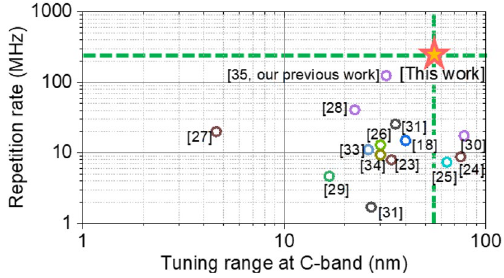
Figure 1. Summary of state-of-the-art C-band tunable mode-locked lasers in terms of the repetition rate and tuning range on the C-band.